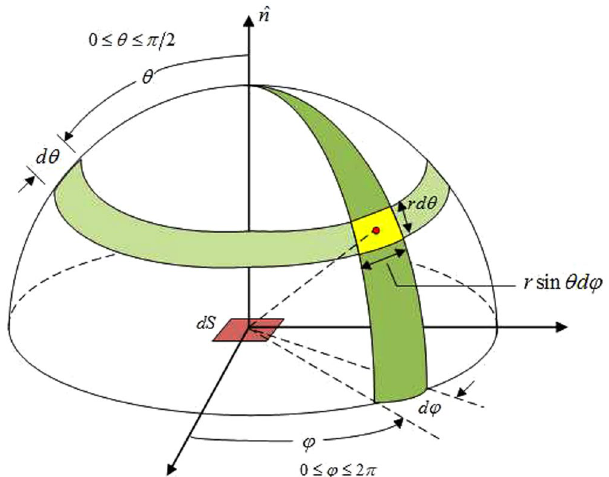
Figure 2. Illustration of the zenith angle and azimuthal angle in the spherical coordinate